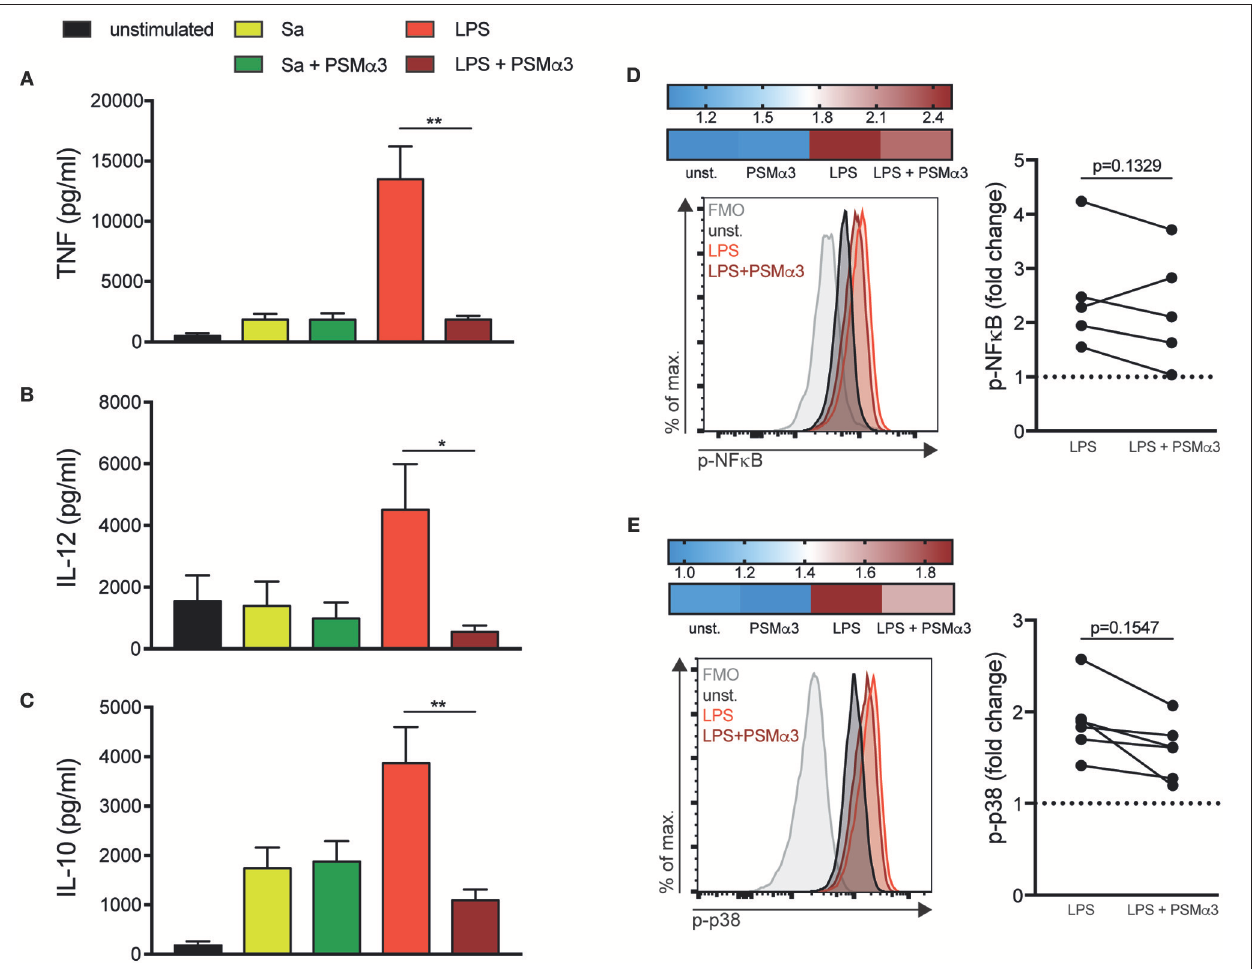
FIGURE 2 | PSMs impair pro- and anti-inflammatory cytokine secretion by moDCs. (A–C) MoDCs were treated with Sa lysate or LPS with or without PSM α 3 for 6h (A) or 24h (B,C) . The cell culture supernatants were collected and analyzed for TNF (A) , IL-12 (B) and IL-10 (C) production by sandwich ELISA. The graphs show n ≥ 10 independent experiments (mean ± SD/SEM) performed in triplicates. (D,E) MoDCs were treated with LPS with or without PSM α 3 or PSM α 3 alone for 60min. Thereafter, the cells were stained extracellularly with anti-CD11c and anti-HLA-DR antibodies, followed by fixation, permeabilization and subsequent intracellular staining using anti-phospho-NF- κ B (D) and anti-phospho-p38 antibodies (E) . Representative histogram overlays of p-NF- κ B (D) and p-p38 (E) in DCs (gated on CD11c + HLA-DR + cells). The heat map shows fold-change of p-NF- κ B (D) and p-p38 (E) normalized to untreated DCs (unst.). The graphs show the statistical analysis of p-NF- κ B (D) and p-p38 (E) from n = 5 different donors. * p < 0.05 or ** p < 0.005, Kruskal-Wallis with Dunn’s posttest or one-way ANOVA with Turkey’s posttest.